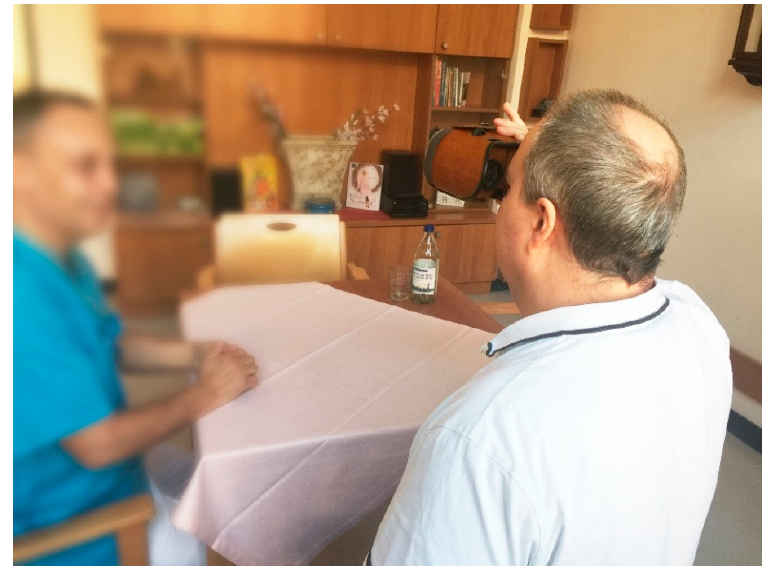
Figure 11. The “Binoculars” in a daycare setting.